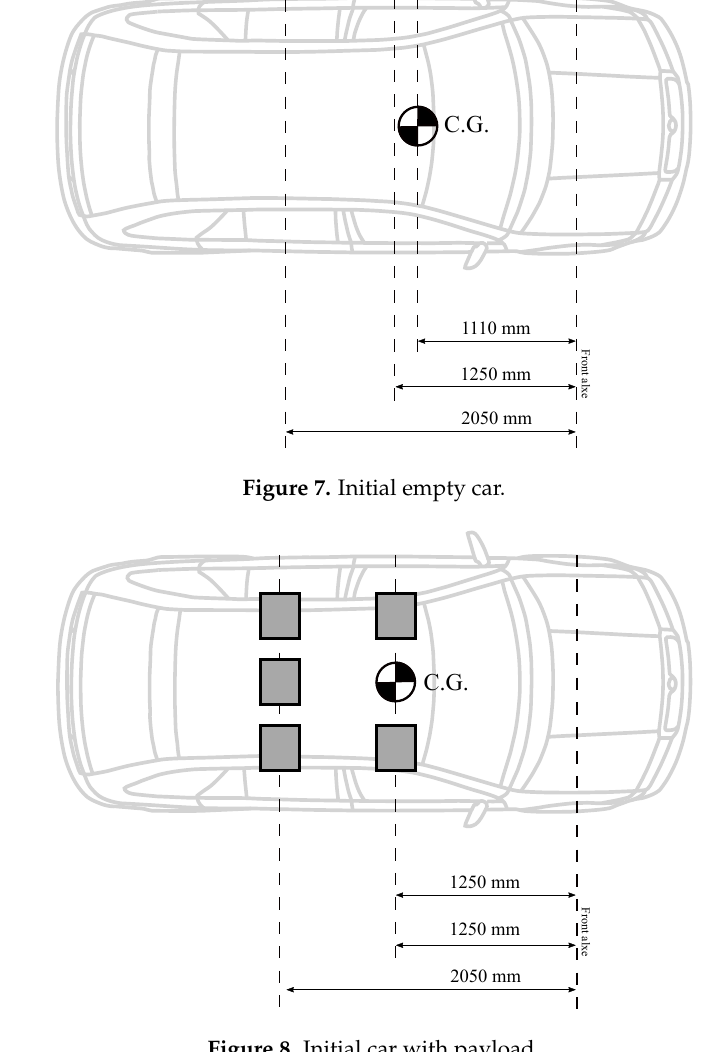
Figure 8. Initial car with